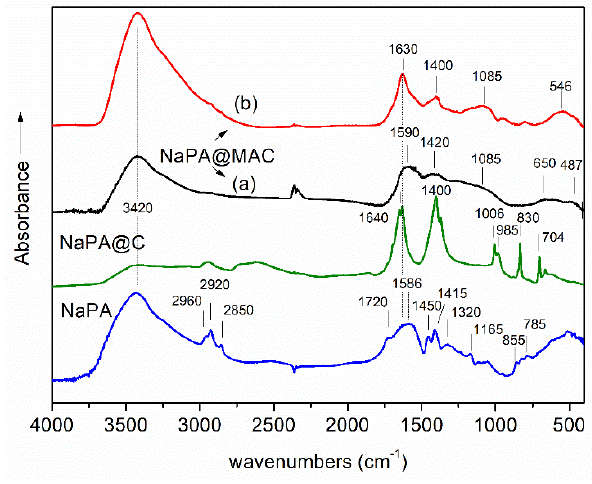
Figure 1. FT-Infrared spectra of samples: NaPA, NaPA@C, and NaPA@MAC before (a) and after treatment with the 48 ppm Cr(VI) solution for 24 h (b). Schemes follow the same formatting.